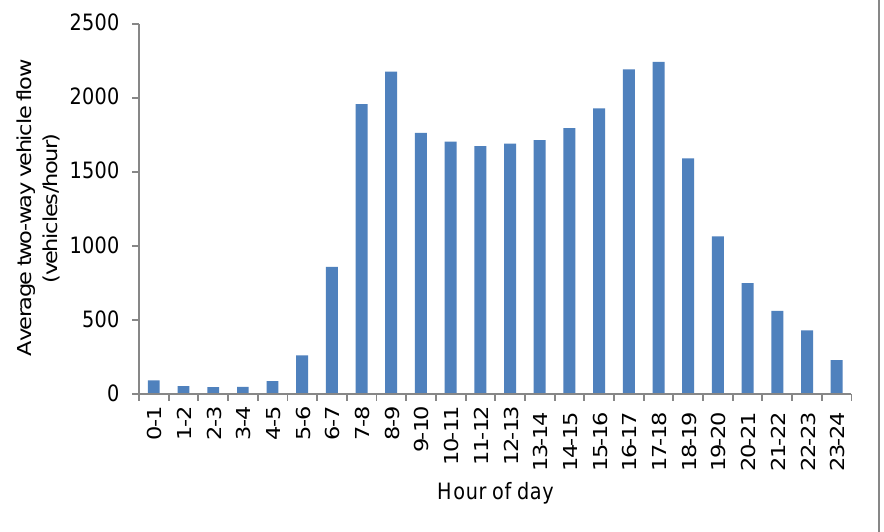
Figure 3. Variation in weekday two-way flow, 2013, at site #3 on the A354 (see Figure